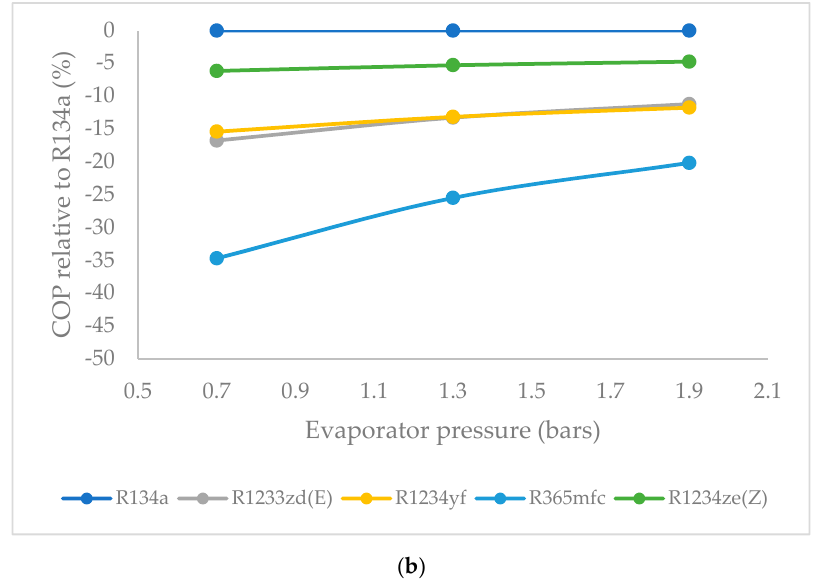
Figure 11. ( a ) COP as a function of evaporator pressure (condenser pressure = 9 bar). ( b ) COP relative to R134a (%) (condenser pressure = 9 bar).